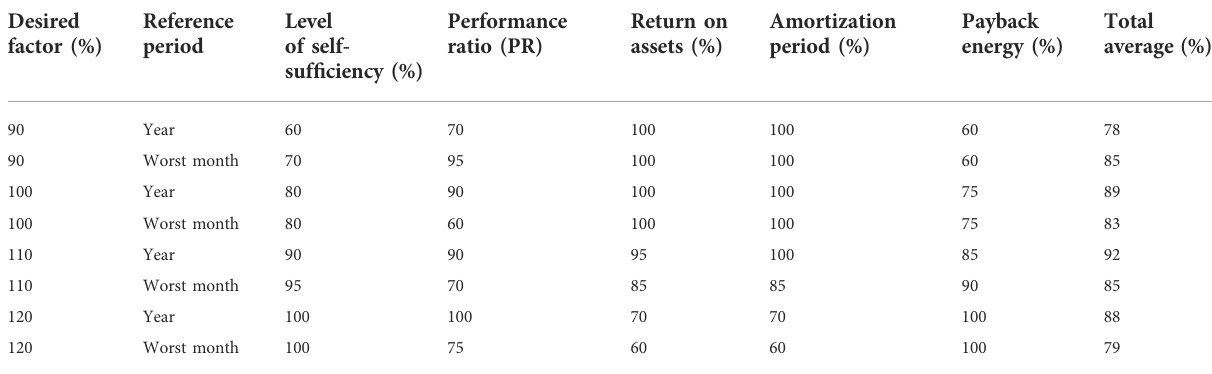
TABLE 7 Simulation results performance analysis.